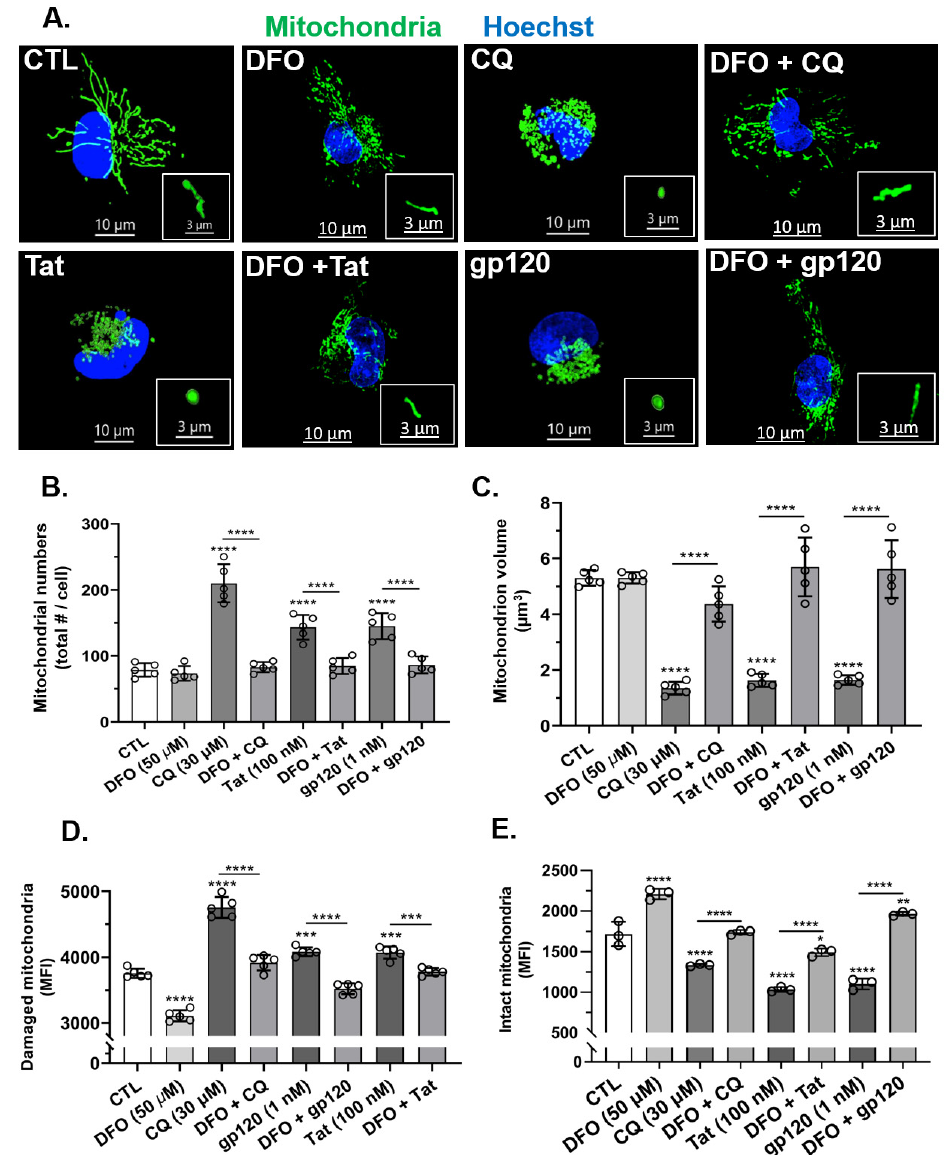
Figure 2. DFO blocked HIV-1 Tat-, gp120-, and CQ-induced increases in mitochondrial fragmentation and decreases in mitochondrial volume (size). ( A ) Representative fluorescence microscope images showing mitochondria (green) and nuclei (blue). DFO blocked CQ-, HIV-1 Tat-, and gp120-induced mitochondrial fragmentation (small and swelled structures) compared to control cells (elongated structures). ( B , C ) DFO blocked CQ-, HIV-1 Tat-, and gp120-induced mitochondrial fragmentation, increased mitochondrial numbers, and decreased mitochondrial volume. ( D , E ) DFO blocked CQ-, HIV-1 Tat-, and gp120-induced increases in damaged mitochondria and decreases in intact mitochondria. Image analysis and quantification was performed on five independent experiments with 30 cells quantified for each experimental condition ( n = 150). Error bars represent standard deviation (SD) of five independent experiments. A one ‐ way ANOVA multiple comparisons test was used to compare control group and treatment group. Cells were chosen randomly during image acquisition and analysis from the microscope field of view, and no cells were intentionally excluded. Scale bars are 10 μ m for the image and 3 μ m for the inset. * p < 0.05, ** p < 0.01, *** p < 0.001 and **** p < 0.0001 .